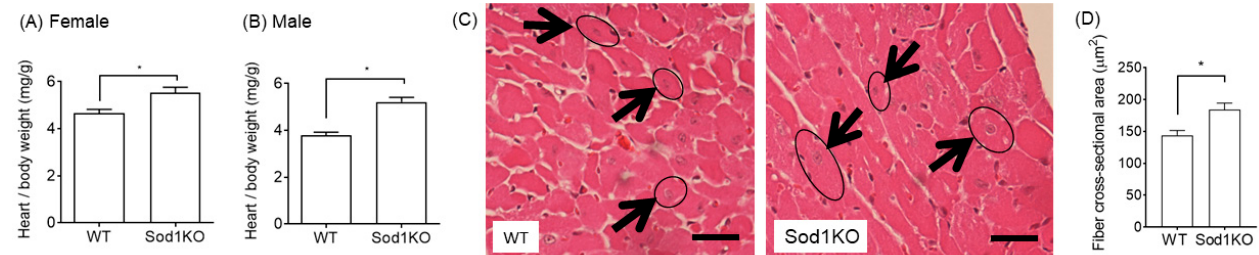
Figure 3. Increase in heart weights in Sod1KO mice. ( A , B ) Heart weights normalized to body weight significantly increased for both male and female mice ( n = 6–8). ( C ) H&E-stained representative cross-section images of hearts from WT and Sod1KO mice. Fibers with central nuclei were analyzed for equal comparisons for fiber cross-sectional area (CSA). Arrows indicate fibers with central nuclei. The scale bar indicates 50 µm. ( D ) Myocyte CSAs were calculated from circumferences of myocytes with round and central nuclei ( n = 4). We analyzed 15–25 fibers from each mouse to determine the mean fiber CSA from each group. * p < 0.05. Data are mean ±